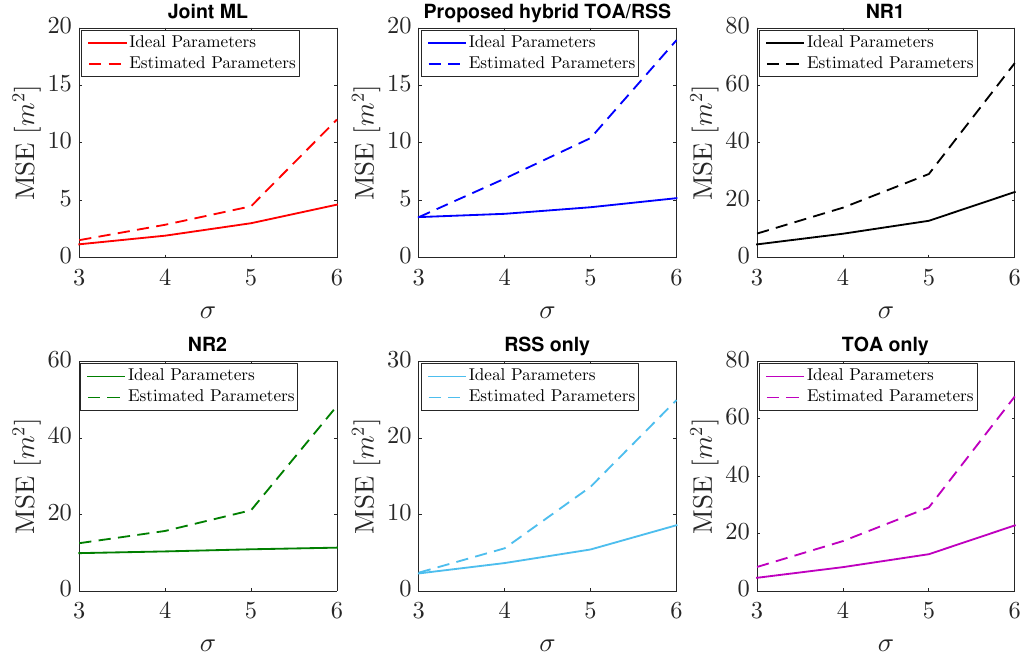
Figure 4. Mean square error (MSEs) of the considered estimators as function of the measurement error σ for α = 2 and N = 8: ideal vs. estimated parameters.